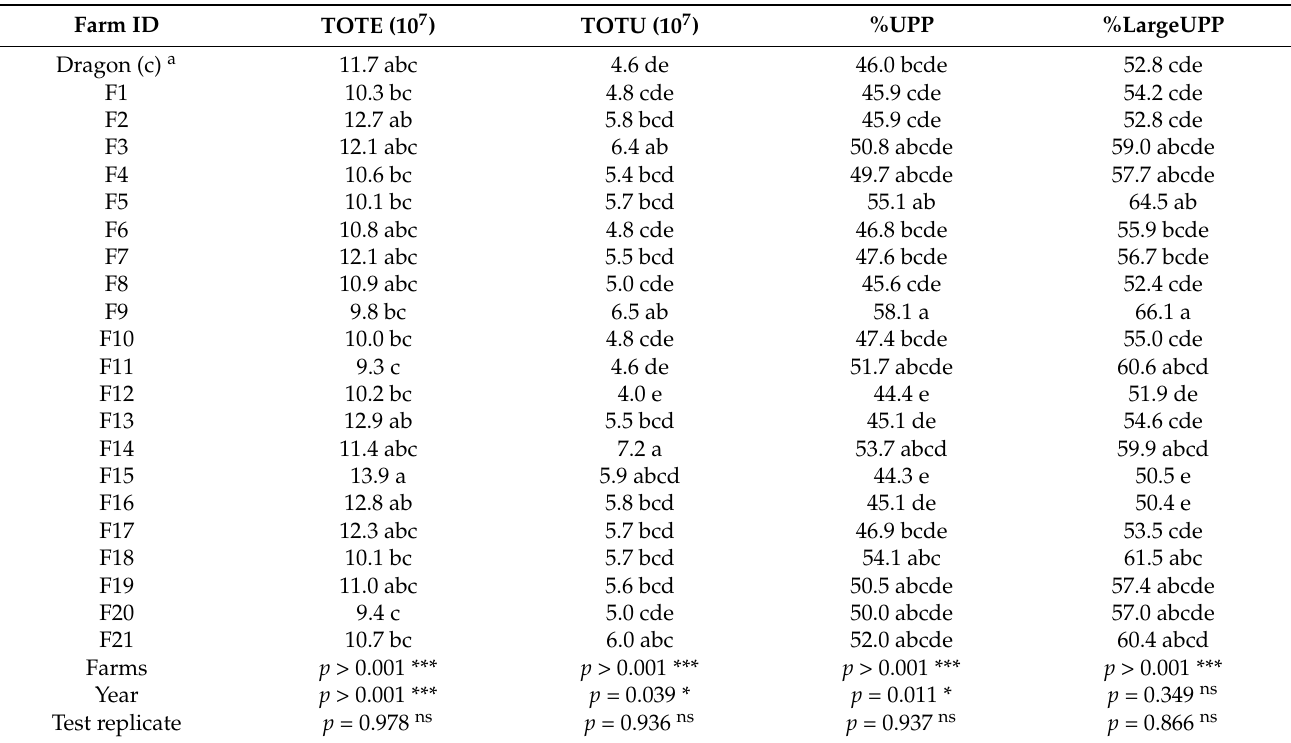
Table 6. Relative amount of various protein fractions determined by SE-HPLC in wheat samples from 21 Tajik farms surveyed, and significance levels for protein factors as related to farm type and study years based on analysis of variance. Farm